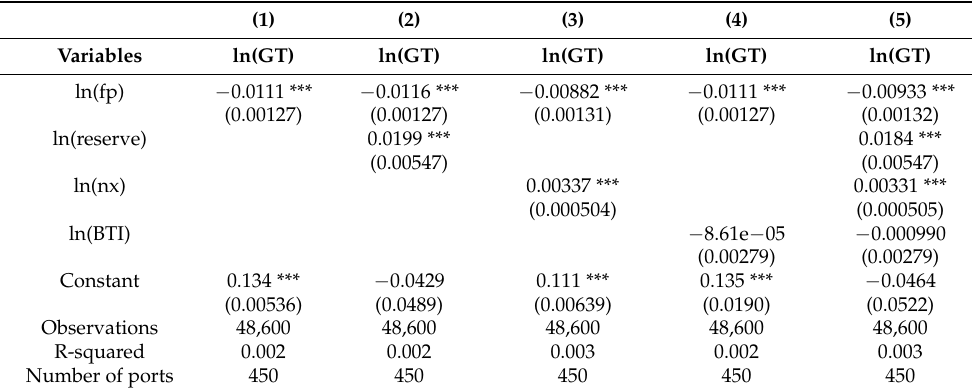
Table 9. Robustness test (GT): from 2011 to 2019.